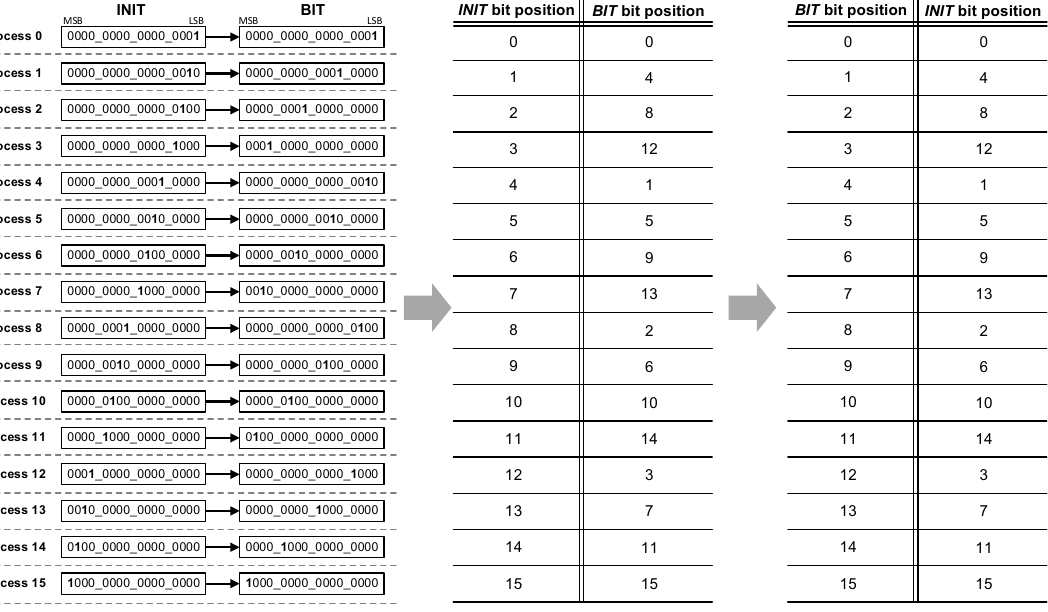
Figure 4. Mapping table construction for the previous method [6].